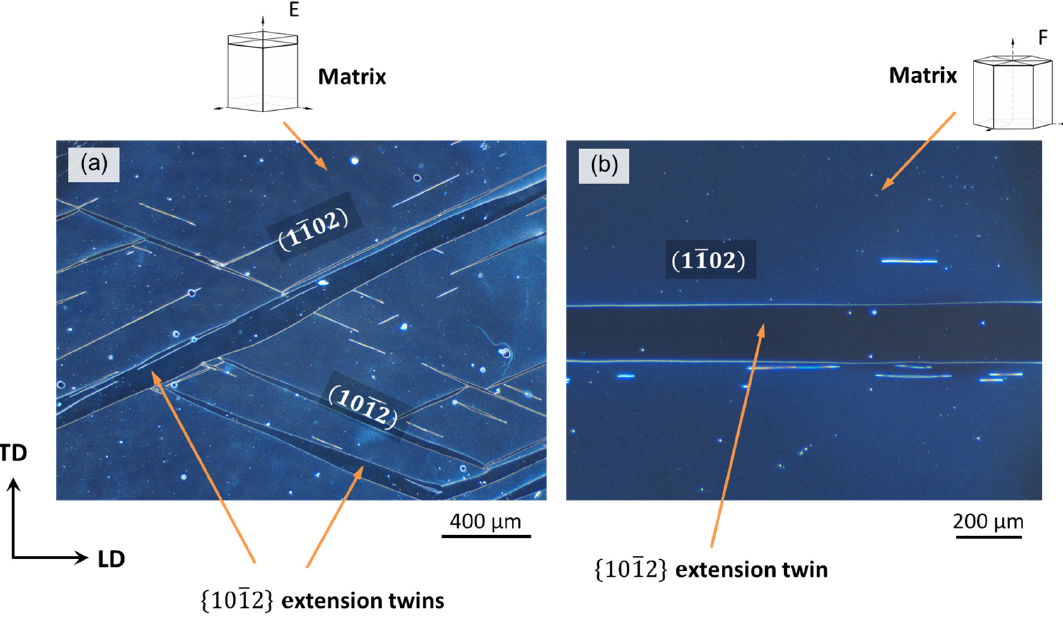
Figure 15. Optical micrographs after PSC tests at room temperature of crystals with ( a ) orientation E and ( b ) orientation F at a true strain of − 3% in the initial rapid hardening region in Figure 14.